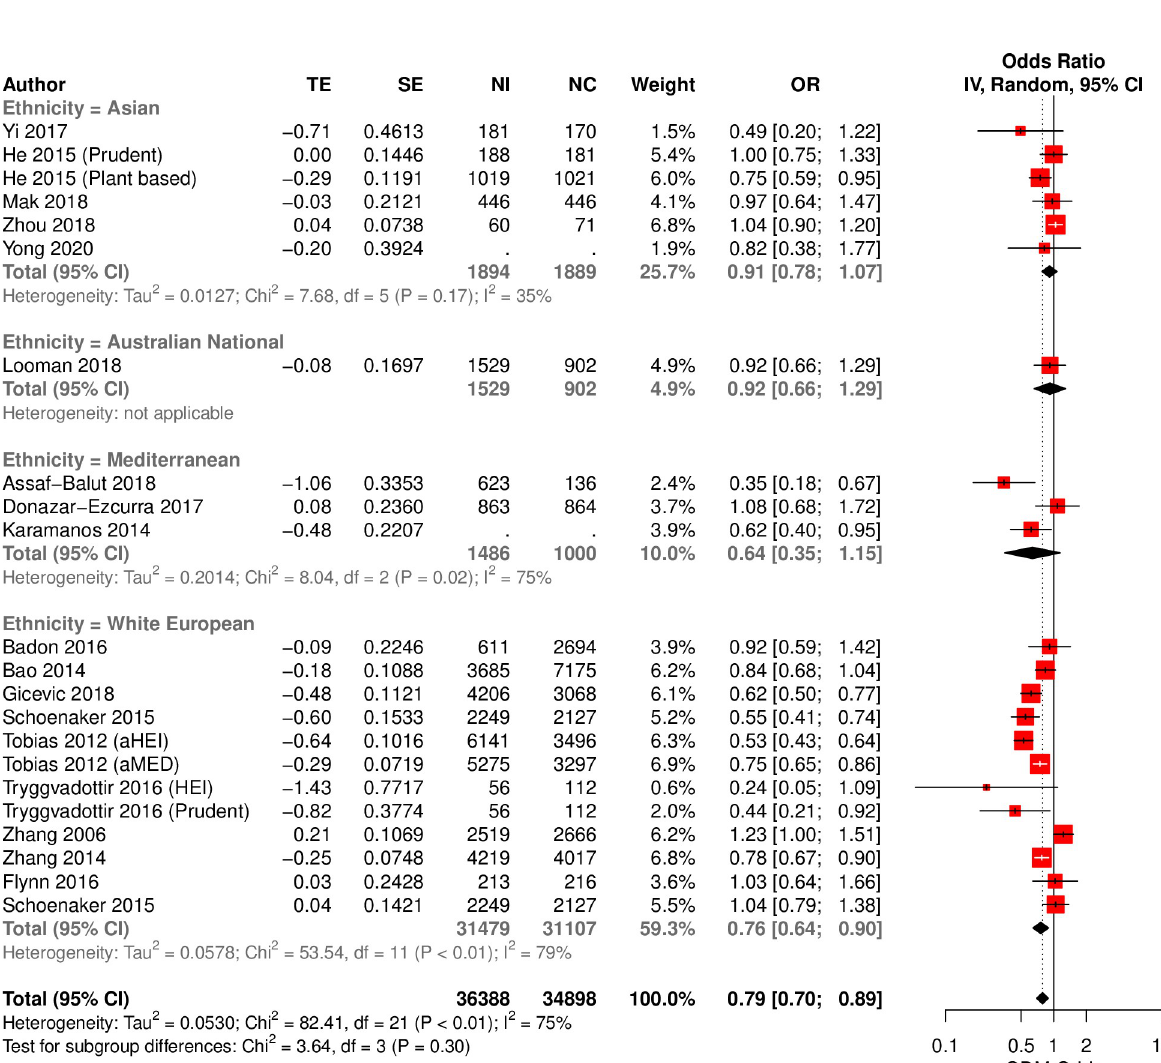
Fig 3. Forest plot of reported associations between healthy dietary interventions and odds of GDM in ethnically–defined observational studies. Forest plot illustrating the association between habitual healthy dietary intake and GDM in distinct ethnicities. TE: treatment effect, SE: standard error, IV: inverse variance method, CI: Confidence